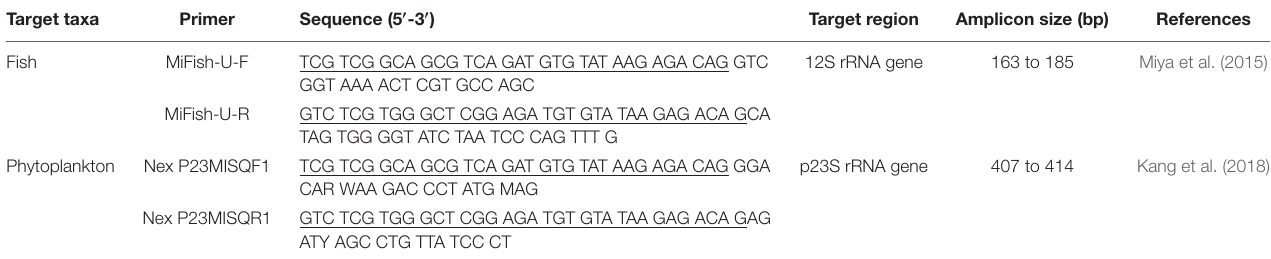
TABLE 1 | Primers used in this